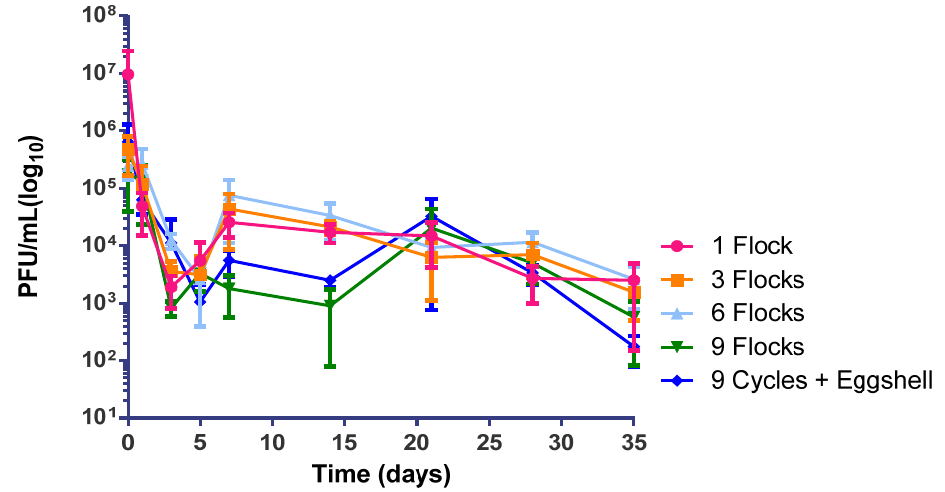
Figure 2. Phage titer over the time after application of phage SM1 in poultry litter with different built-up levels and the addition of an alternative carbonate (eggshell).